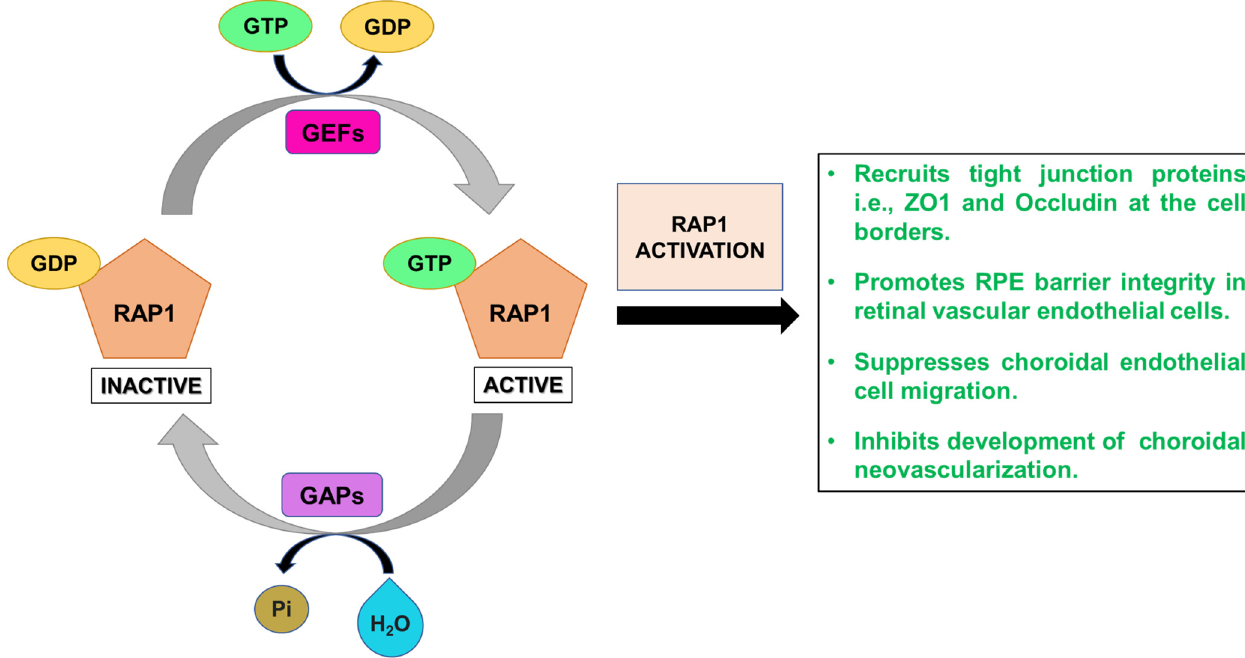
Figure 4. RAP1 ′ s mechanism of action. Inactive RAP1 protein is converted to its active form by GEFs (Guanine nucleotide Exchange Factors) that activate monomeric RAP1 GTPase by stimulating the release of GDP (Guanosine DiPhosphate) to allow binding of GTP (Guanosine TriPhosphate), resulting in active RAP1. Active RAP1 recruits tight junction proteins, i.e., ZO1 and Occludin at the cell borders, promotes RPE barrier integrity in retinal vascular endothelial cells, suppresses choroidal endothelial cell migration, and inhibits development of choroidal neovascularization.